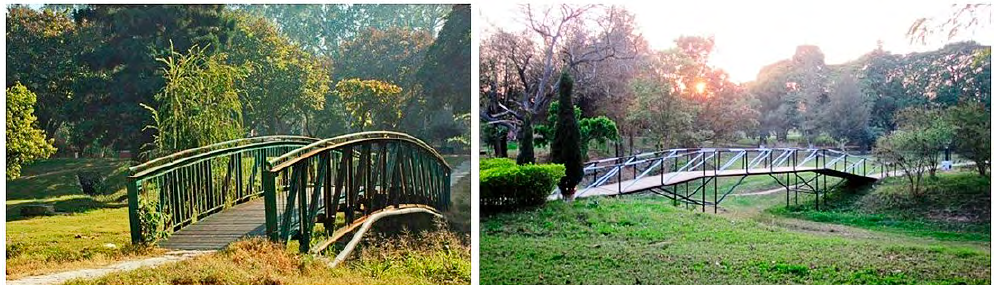
Figure 4. Pedestrian bridges over N-choe in Leisure valley; Source: Chandigarh web portal,